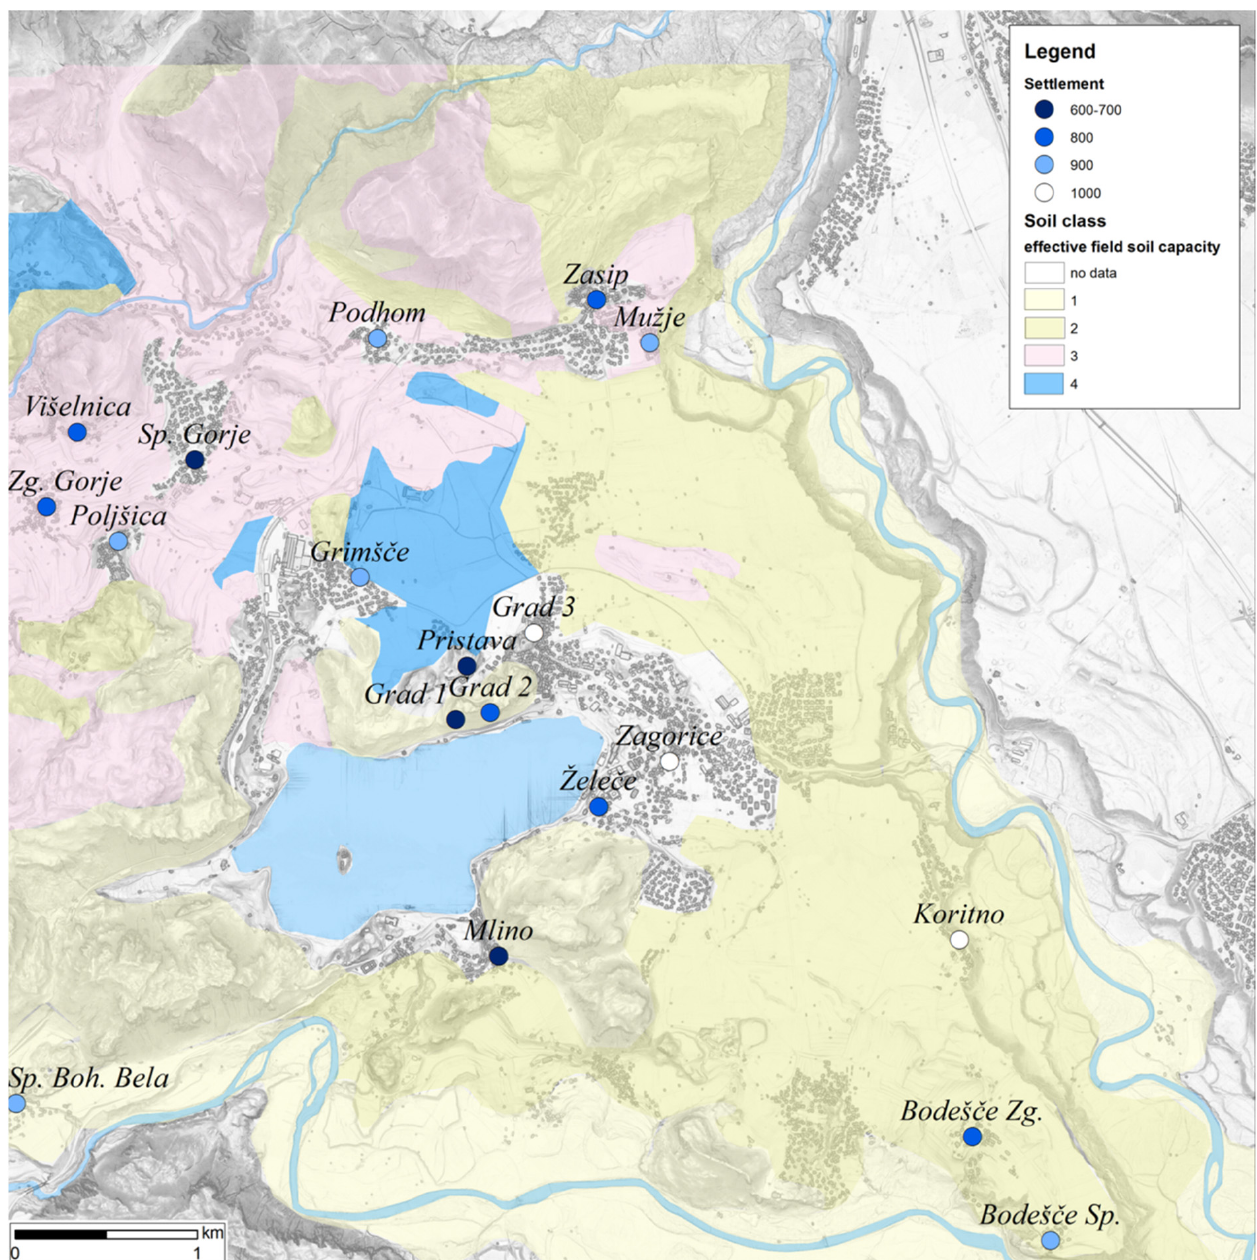
Figure A4. Bled micro-region (decimal longitude and latitude coordinates of the map centre: 14.1139; 46.3752), effective field soil capacity (FC) classes (source data adopted from [94]; North at the top).